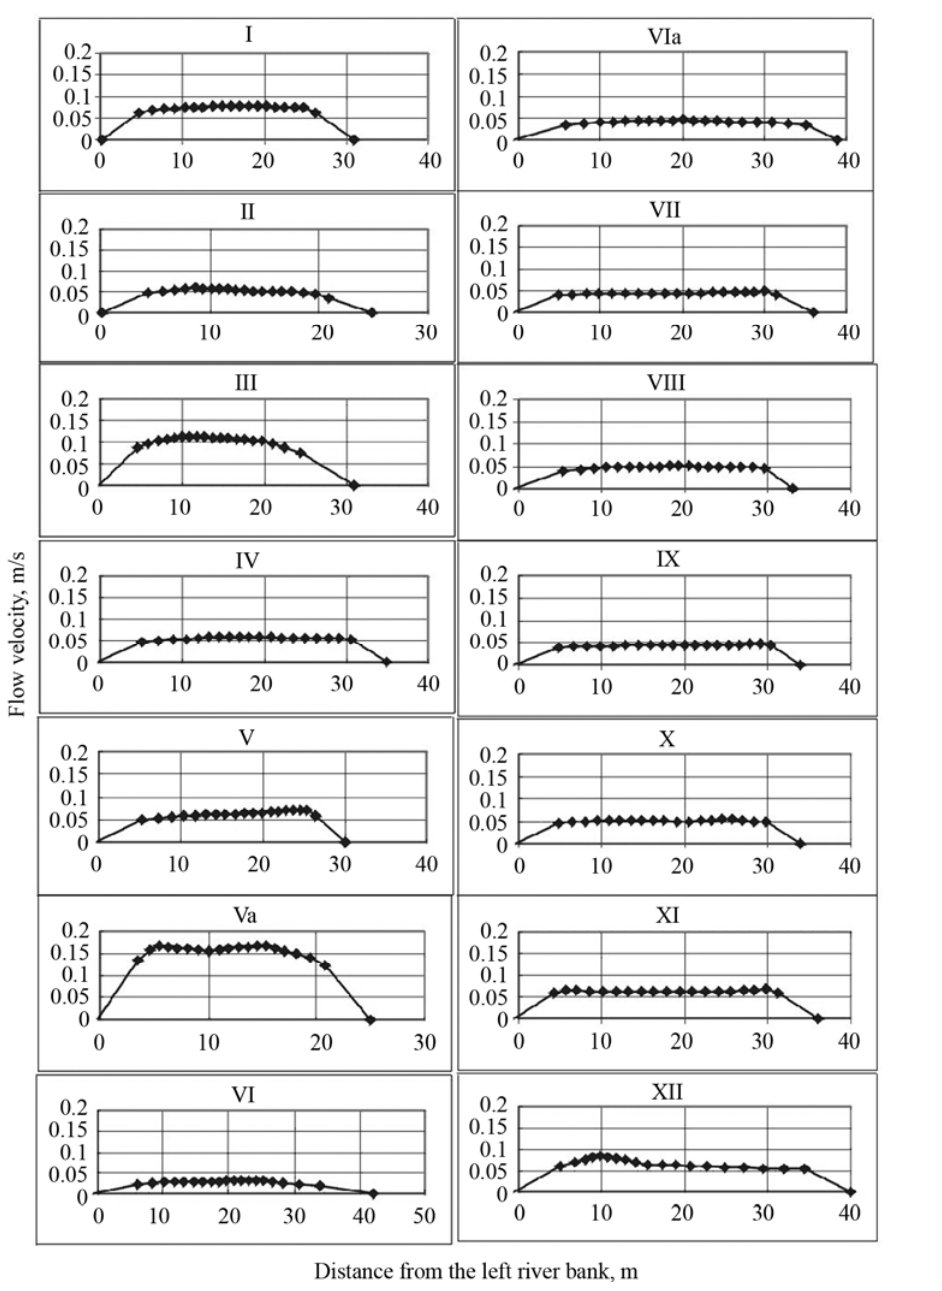
Fig. 6 . Flow velocities m/s at cross-sections I–XII (in dam pond), when discharge is as usual (3 m 3